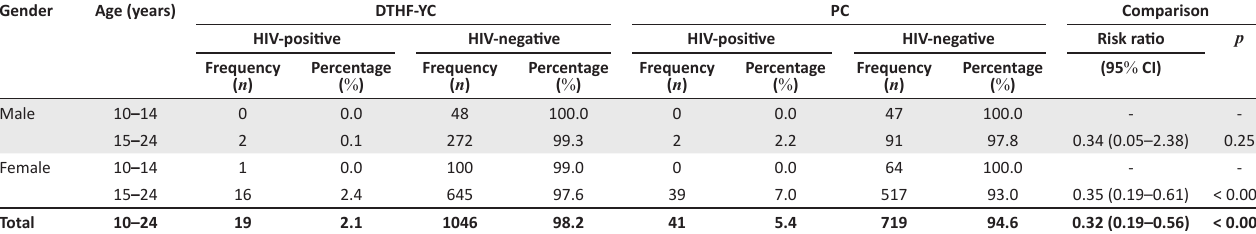
TABLE 3: 2015 Desmond Tutu HIV Foundation Youth Centre versus public clinic HIV Counselling and testing results. Gender